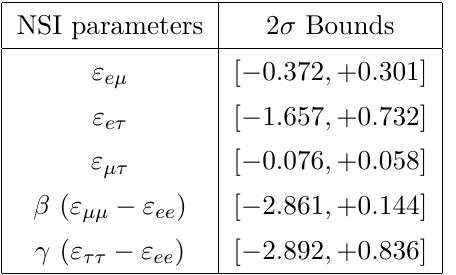
where Y = N + N ) is the relative electron number density of the medium and ρ is / ( N e e p n the Earth matter density. For the Earth matter which is the focus of our paper, it is safe to assume neutral and isoscalar matter, i.e. N relative electron number density inside the Earth turns out to be Y